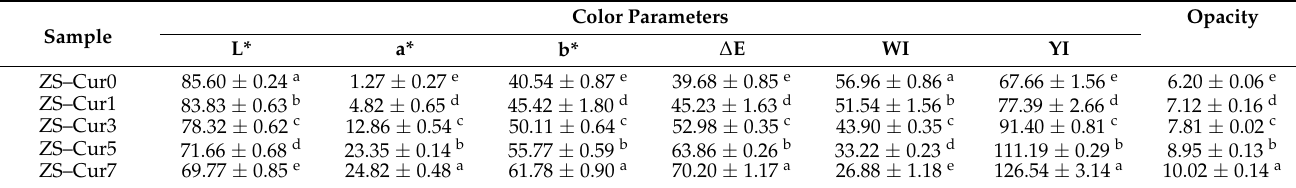
Table 2. Optical properties of zein/shellac film loaded with different curcumin